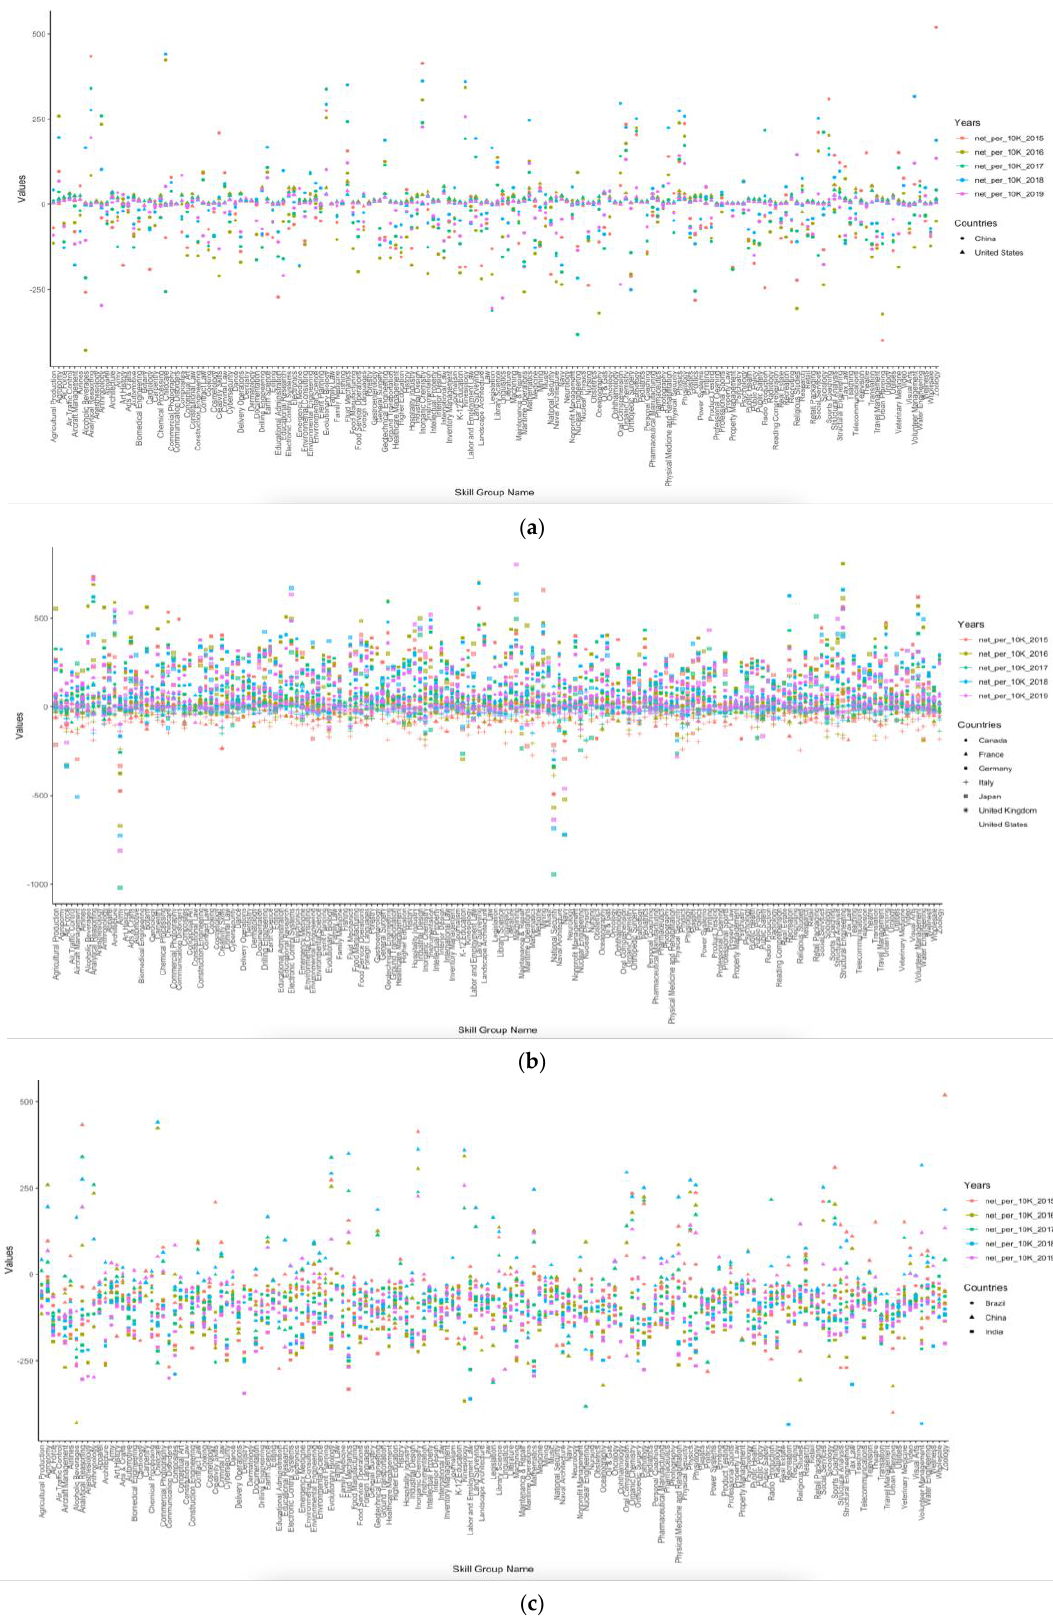
Figure 3. Specialized industry skills migration in ( a ) China and the US, ( b ) G7 countries, and ( c ) BIC countries.